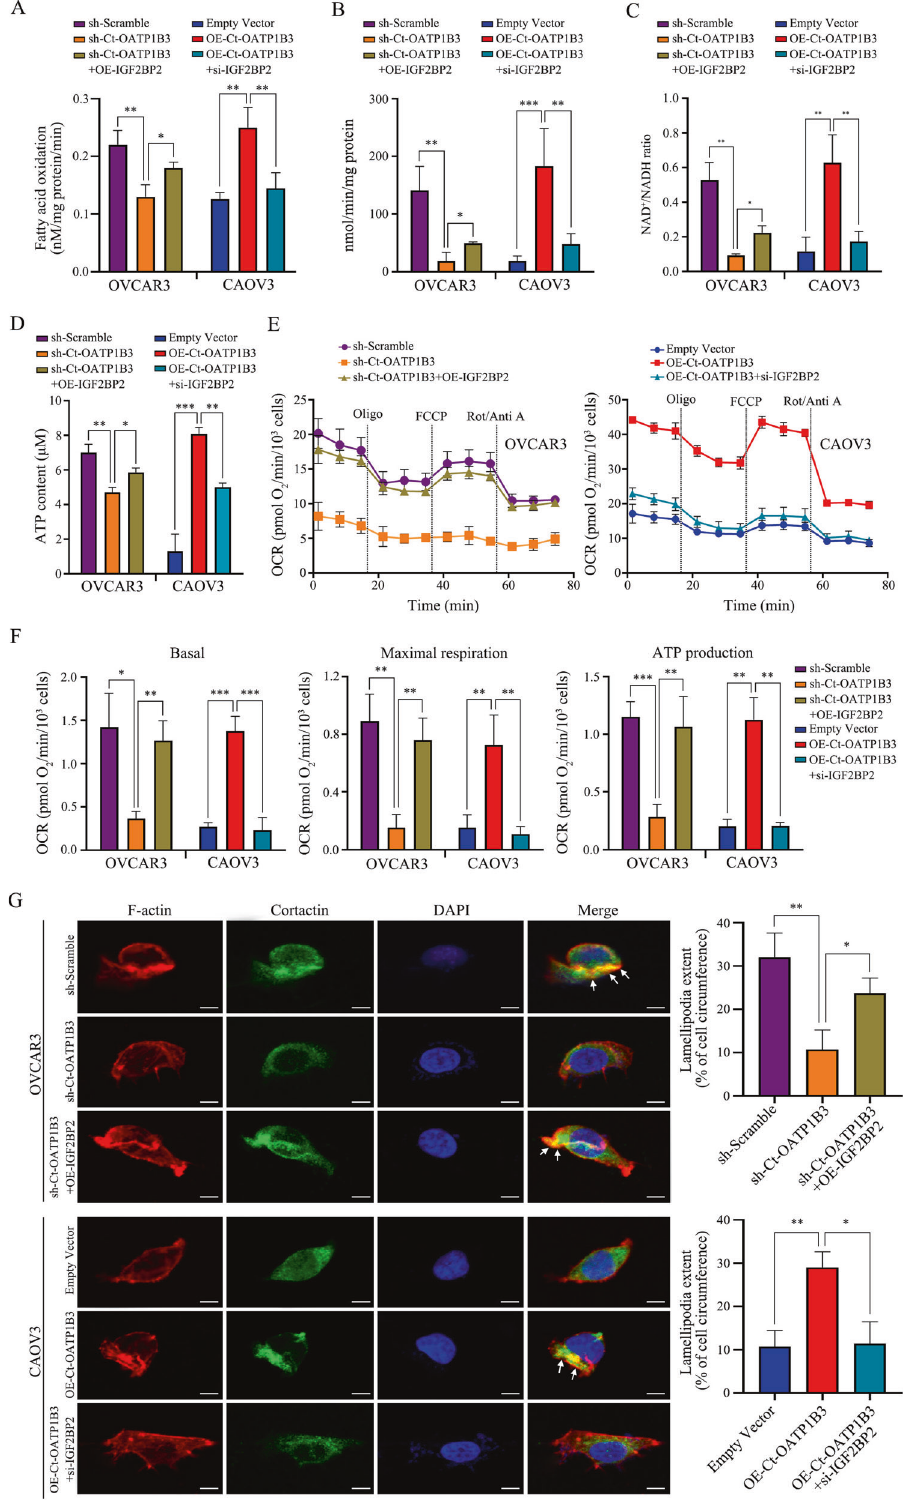
Fig. 6 Ct-OATP1B3 enhances the mitochondrial FAO and OXPHOS activities and promotes lamellipodia formation in HGSOC cells. A Ct- OATP1B3 increases FAO oxidation rate in HGSOC cells. B – D Ct-OATP1B3 increases mitochondrial complex I activity ( B ), NAD + /NADP ratio ( C ), intracellular ATP level ( D ) in HGSOC cells. E , F Seahorse assays demonstrate that Ct-OATP1B3 promotes OCR in HGSOC cells. G Ct-OATP1B3 promotes the formation of lamellipodia in HGSOC cells. Lamellipodia extents at cell edges are quanti fi ed as a percentage of the cell circumference on 100 randomly selected cells in each group. Arrows indicate sites of lamellipodia extension. Scale bar, 10 μ m. * P < 0.05, ** P < 0.01, *** P < 0.001.